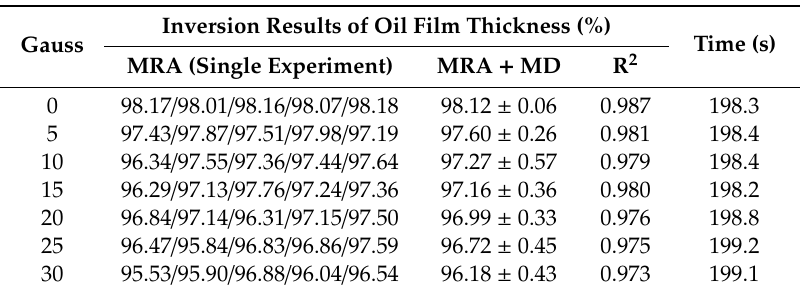
Table 8. Model stability test experiment inversion results.